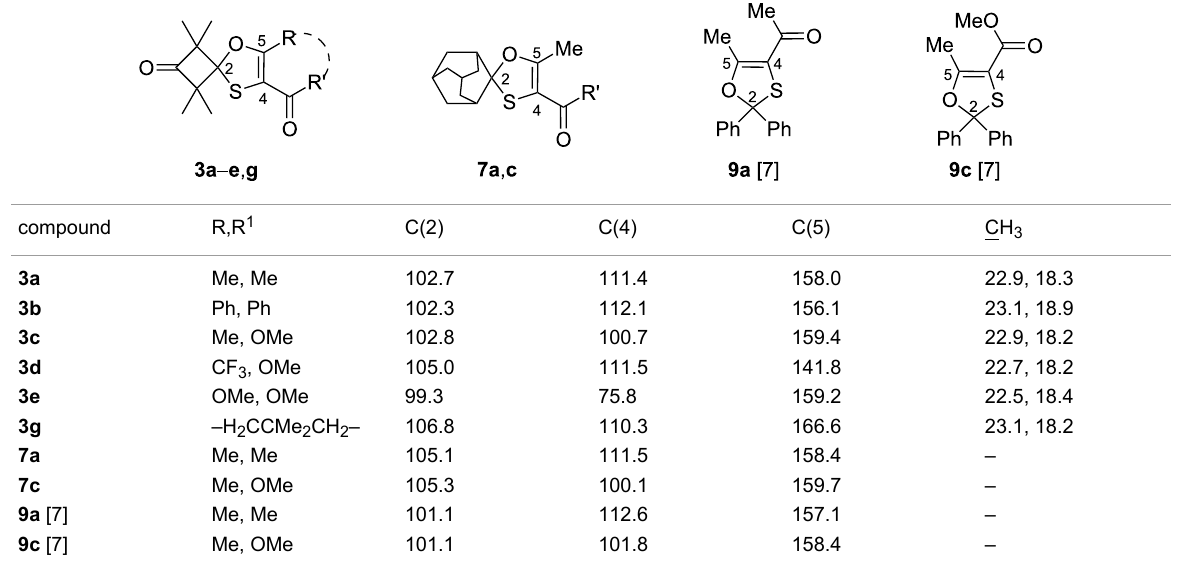
Table 3: The key parameters ( δ , ppm) of the 13 C NMR spectra of 1,3-oxathioles 3a – e , g and 9a , c (see also [7]).